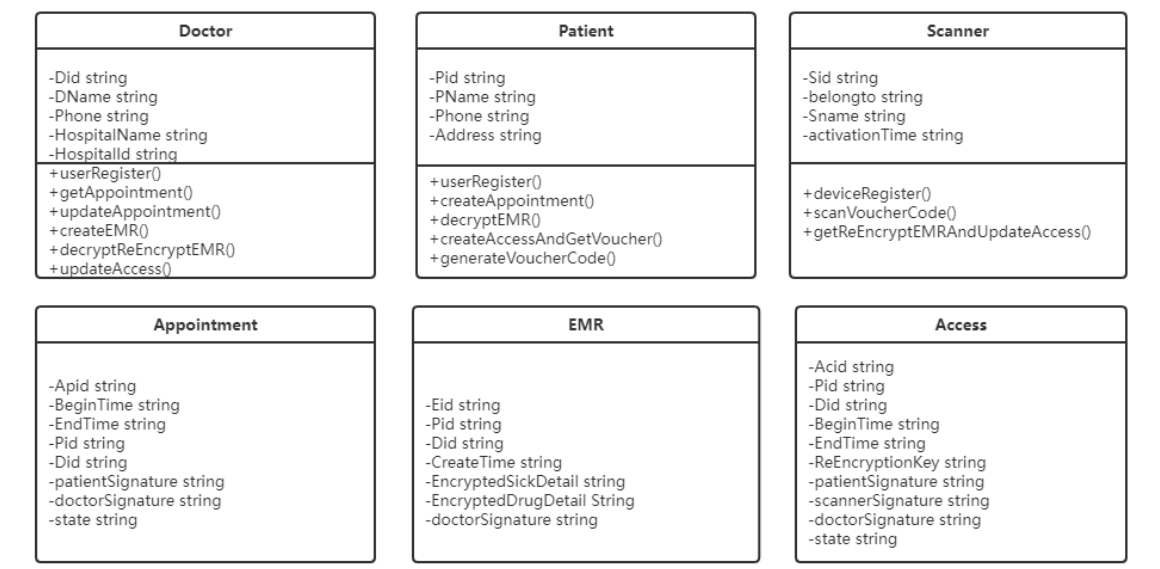
Figure 5. The chaincode data structure. Table 1. Data Structure in CBSC.